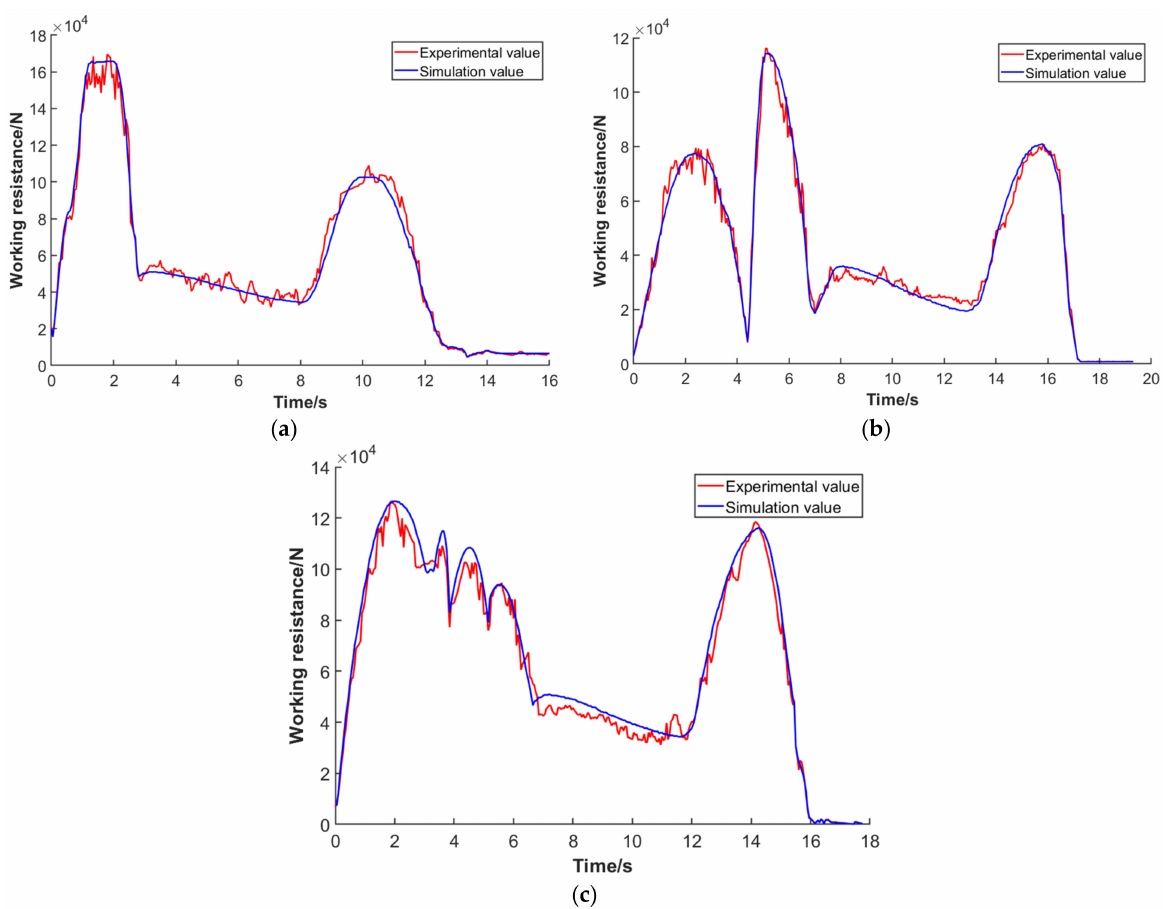
Figure 11. Comparison of test and simulation working resistance of the “V”-type cyclic operation in three modes: ( a ) one-time lifting from the bottom, ( b ) segmentary excavation, ( c ) driver’s experience